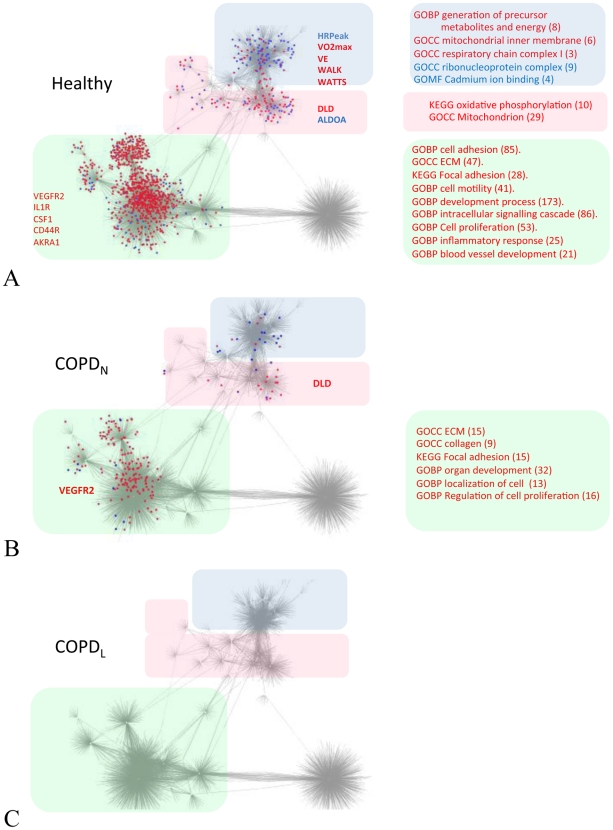
Training response of healthy and COPD individuals visualized on the integrated 8 weeks training network.The networks represent the genes up-regulated (marked in red) and down-regulated (marked in blue) mapped on to the interaction map inferred using the 8 weeks training multi-measurement dataset (shown in detail in
Figure 1
). Panel A shows genes differentially regulated after training in healthy individuals. Panel B shows genes differentially expressed after training in N-BMI COPD patients. Network hubs representing genes up-regulated (red) or down-regulated (blue) are listed on the side of the relevant sub-networks. The drastic reduction in the molecular response to training associated with the cytokine and bioenergetics clusters is evident. Panel C shows the lack of response to training in COPDL patients.